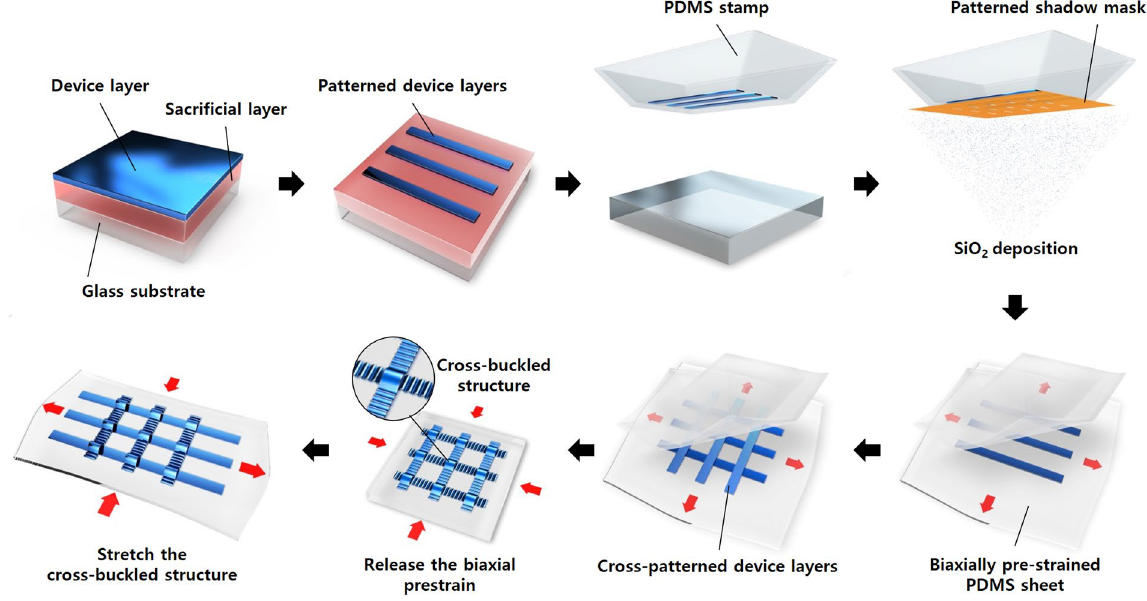
Figure 1. Schematic illustration of the procedure for the fabrication of cross-buckled